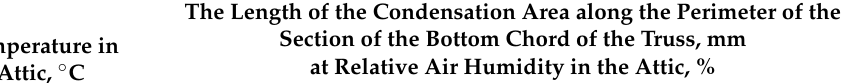
Table 2. The length of the condensation area along the perimeter of the section of the bottom chord of the truss, depending on the temperature and relative humidity of the air in the attic (calculation scheme with a gusset plate: the gaps between the angles and precast reinforced concrete elements are filled with thermal insulation).